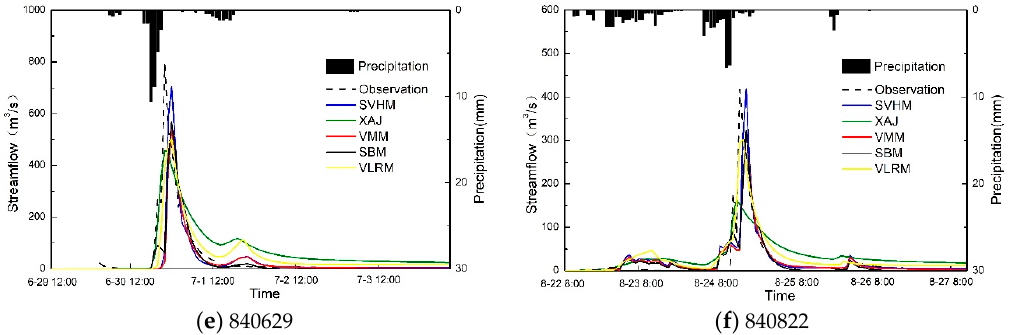
Figure 7. Comparisons of simulated and observed streamflow for some flood events in Chutoulang Basin (( a – d ) are calibration and ( e , f ) are validation).